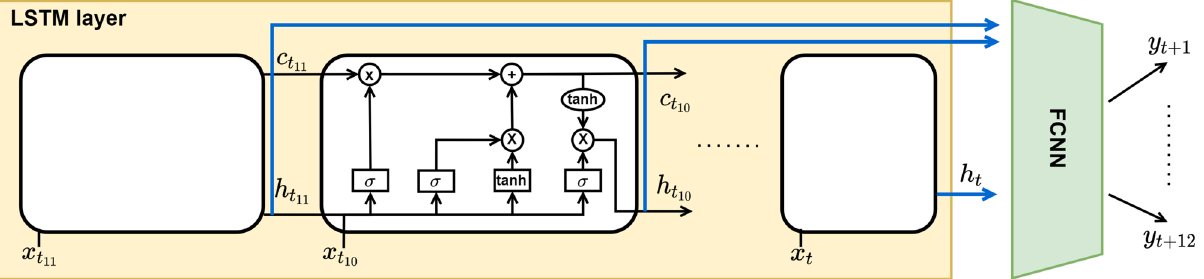
Figure 2. Neural Network architecture used to forecast the Dst index as described in the text. In the LSTM cell, the square blocks are Fully Connected layers with activation function, while the circles are elementwise